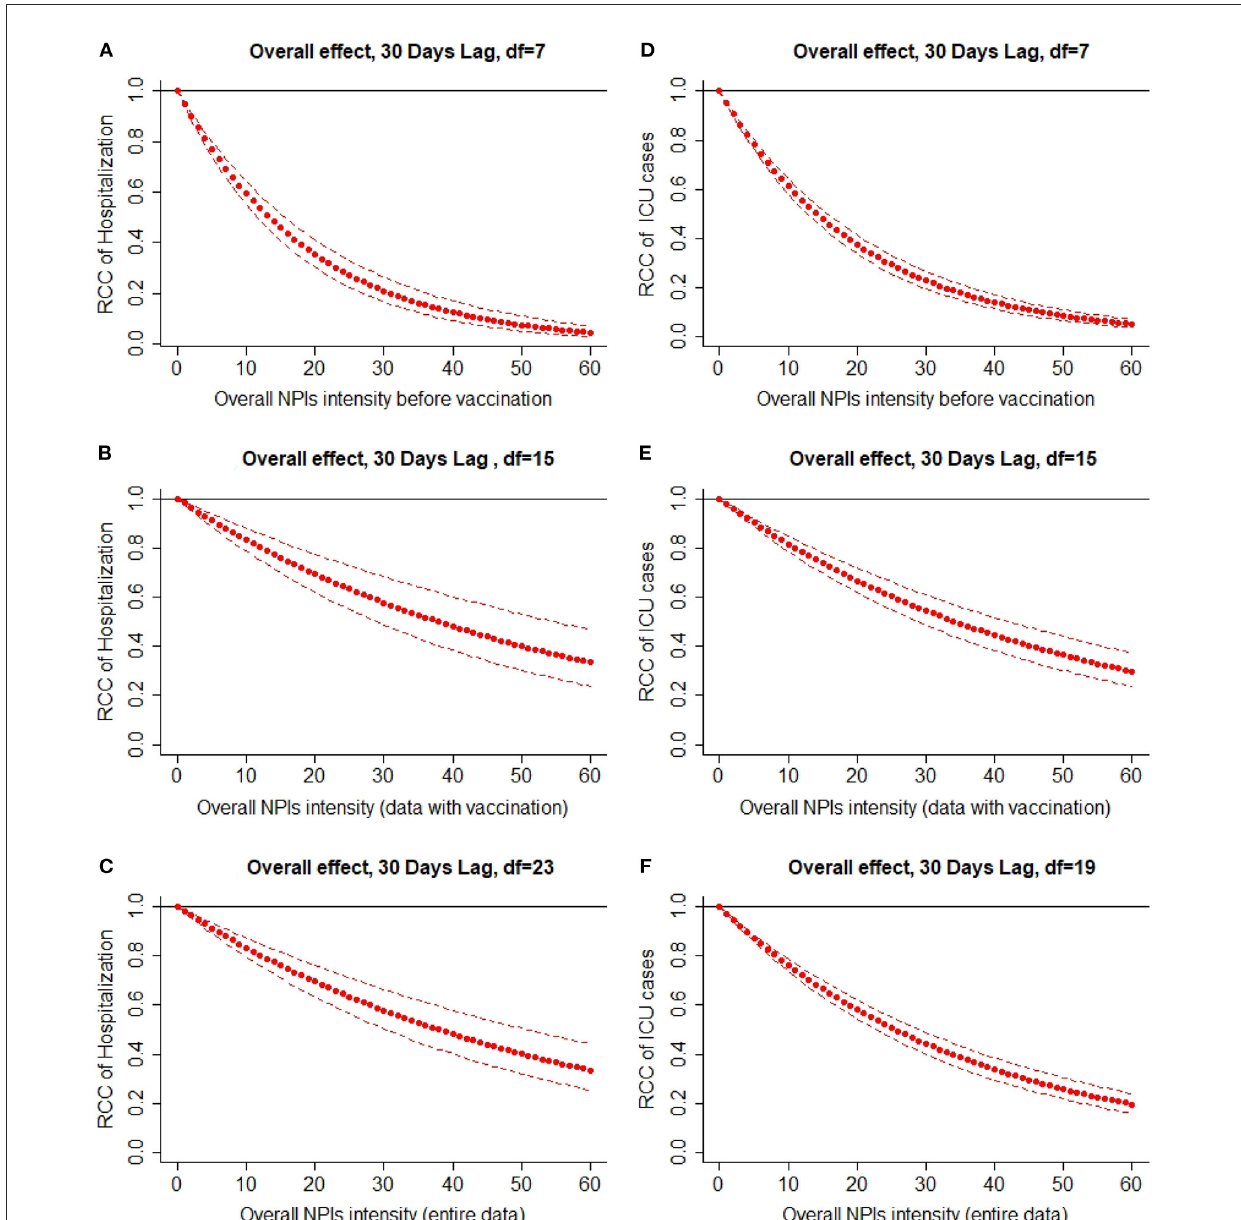
FIGURE2 Overall lag effect of NPIs intensity on the number of incident hospital patients (Hospitalized cases) and the number of prevalent intensive care patients (ICU cases) with 95% confidence intervals. (A) Overall effect, 30 days lag, df = 7, (B) overall effect, 30 days lag, df = 15, (C) overall effect, 30 days lag, df = 23, (D) overall effect, 30 days lag, df = 7, (E) overall effect, 30 days lag, df = 15 and (F) overall effect, 30 days lag, df =